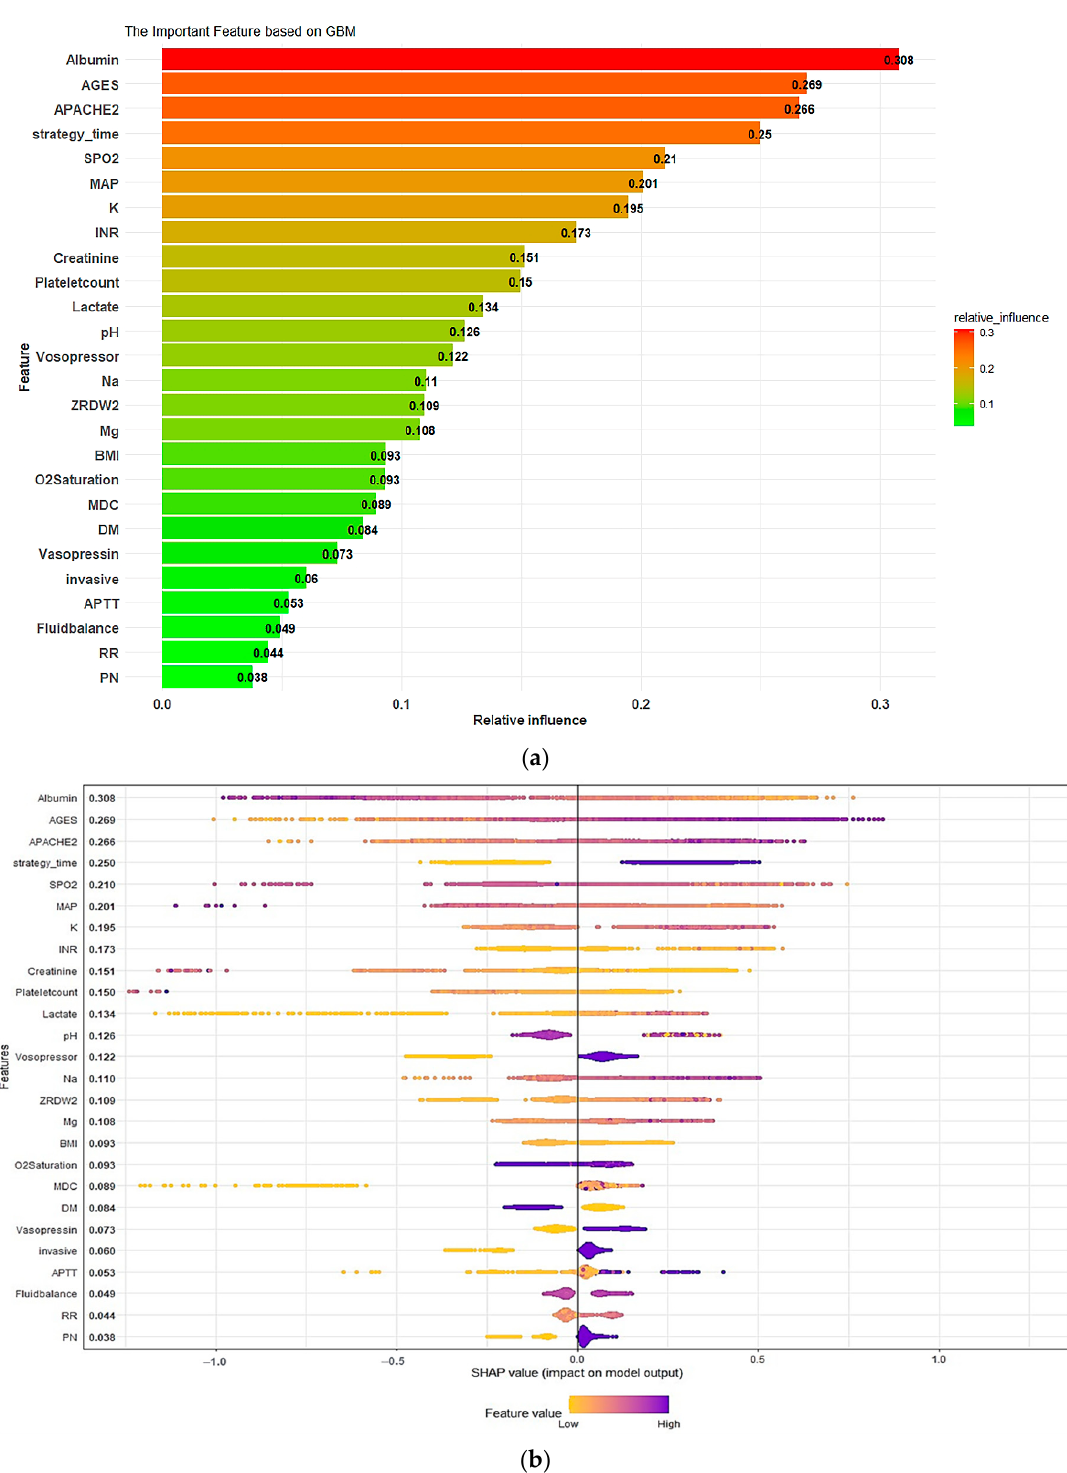
Figure A1. Summary SHapley Additive exPlanations (SHAP) plot. ( a ) Global feature importance in final GBM model output. ( b ) Relationship between features and in-hospital mortality in GBM model. Diversion on x -axis represents effect on model output, with colors used to represent low (yellow) to high (purple) value of predictors.